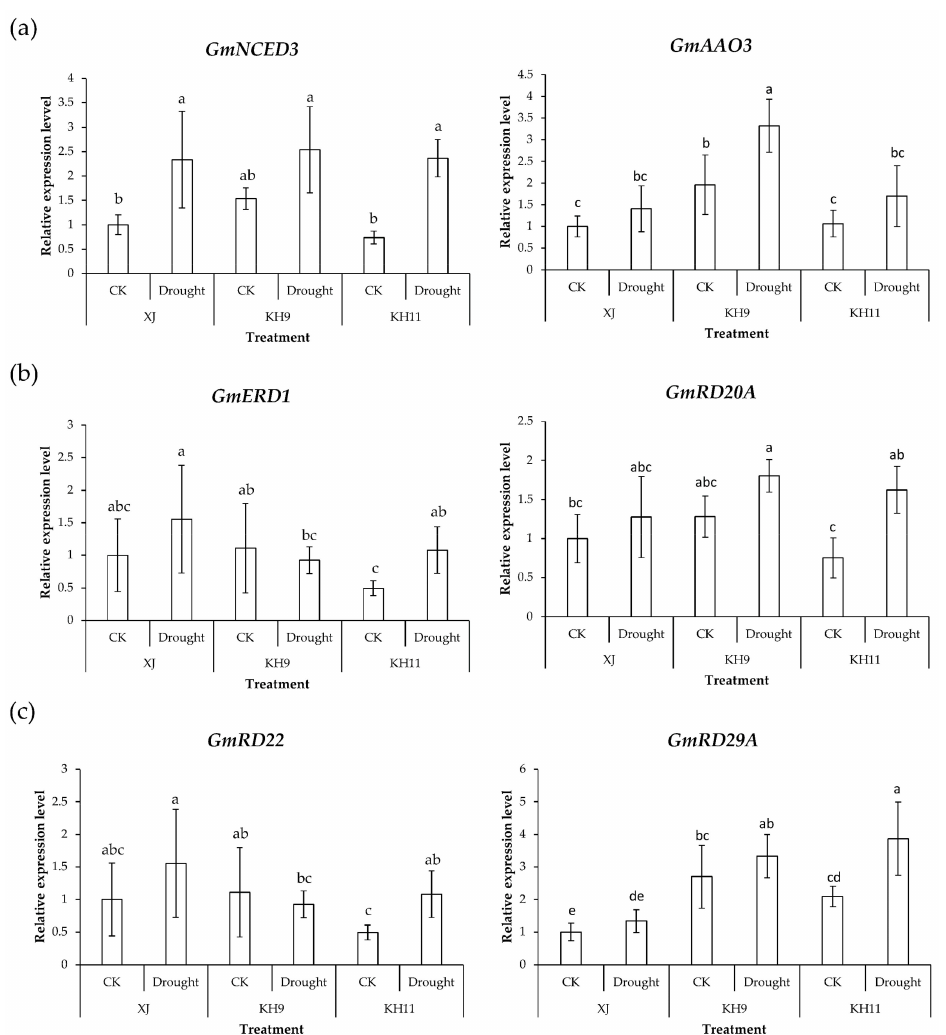
Figure 5. Transcript levels of drought-related genes in XJ, KH9, and KH11 under normal and drought stress conditions. Expression levels of genes in the ( a ) ABA biosynthesis pathway, ( b ) ABA-dependent pathways, and ( c ) ABA-independent pathways under drought stress. Values represent the mean ± SD of three biologically independent experiments. Different letters indicate significant differences between cultivars assessed using the LSD post hoc test ( p < 0.05). XJ, Xiang-Ji.